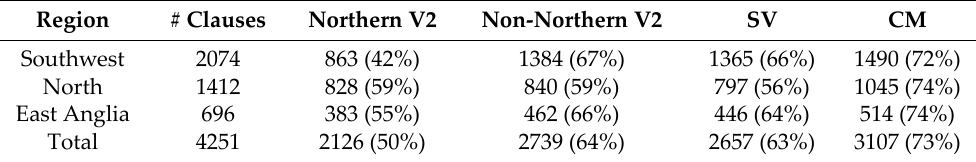
Figure 7. Proportion of clauses in each text in PLAEME which can be generated by the northern V2 grammar ( top left ), the non‑northern V2 grammar ( top right ), the CM grammar ( bottom left ), and the SV grammar ( bottom right ). Each dot corresponds to a text; the size of the dot corresponds to the amount of clauses included from that text; the colour indicates the proportion of clauses in the text that can be generated by the grammar in question. Table 2. Parsing success of four competing grammars in three different